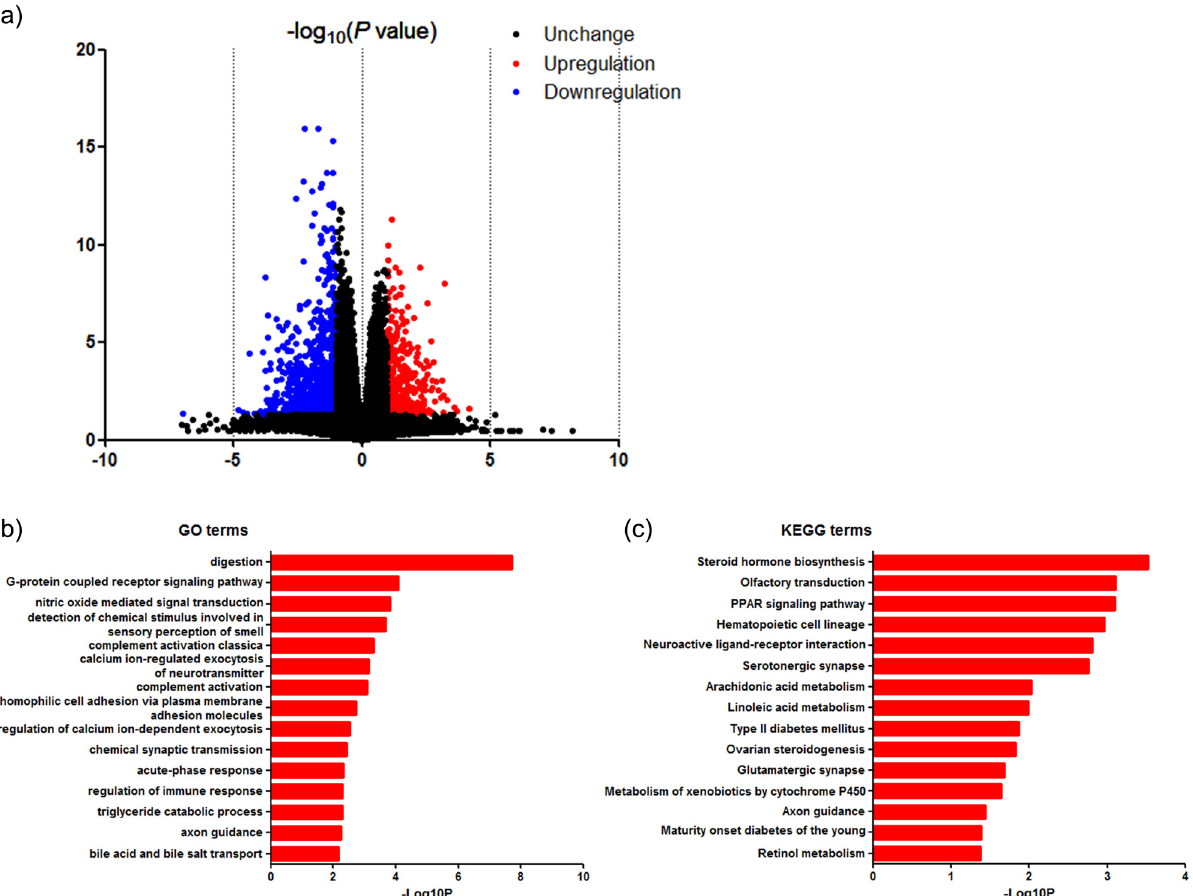
Figure 4: DAVID enrichment results of DEGs. ( a ) Volcano plot for DEGs. ( b ) The GO enrichment results of DEGs. ( c ) The KEGG pathway analysis of